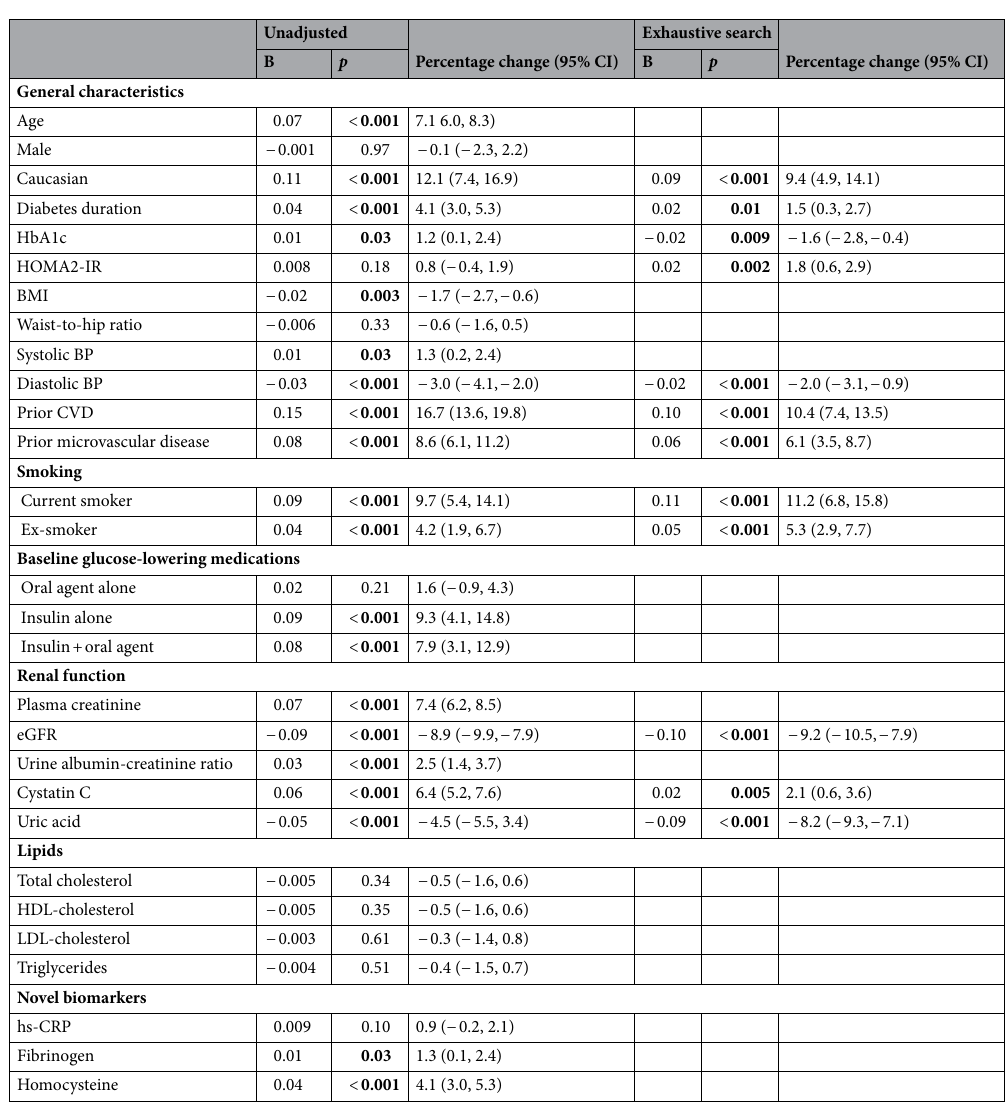
Table 2. Relationship between baseline variables (standardised*) and LMW-F levels at baseline. p values < 0.05 are bolded *Continuous variables have been standardised such that results relate to a 1 SD change. Due to high correlation between plasma creatinine and eGFR (r = − 0.80), only eGFR was included in multivariable